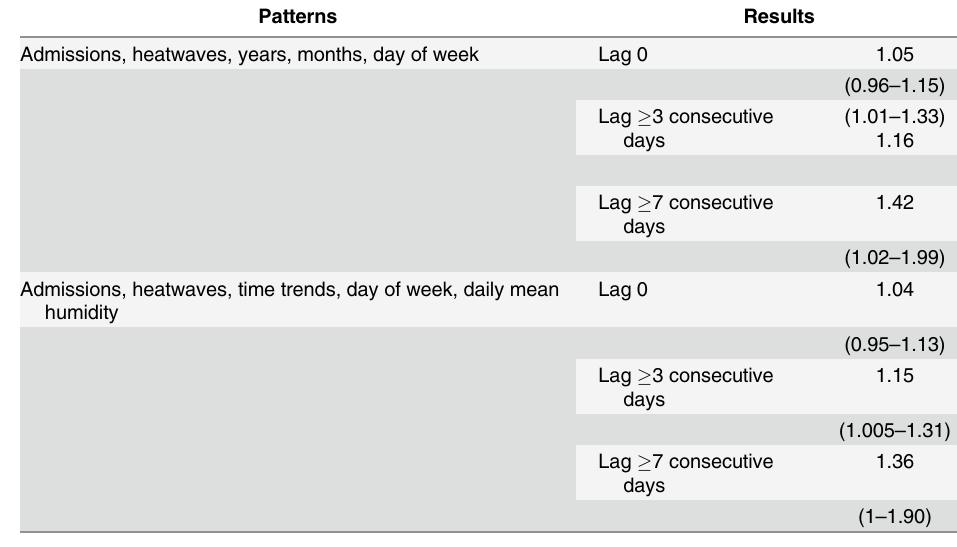
Table 5. The difference of estimates between: adjusting seasonality, time trends using a cubic spline function and only controlling month, year indicators.